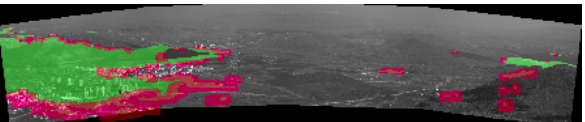
where cen : image patch showing the object, sur : image patch showing surrounding of the object, thr mode : real moving object threshold value.